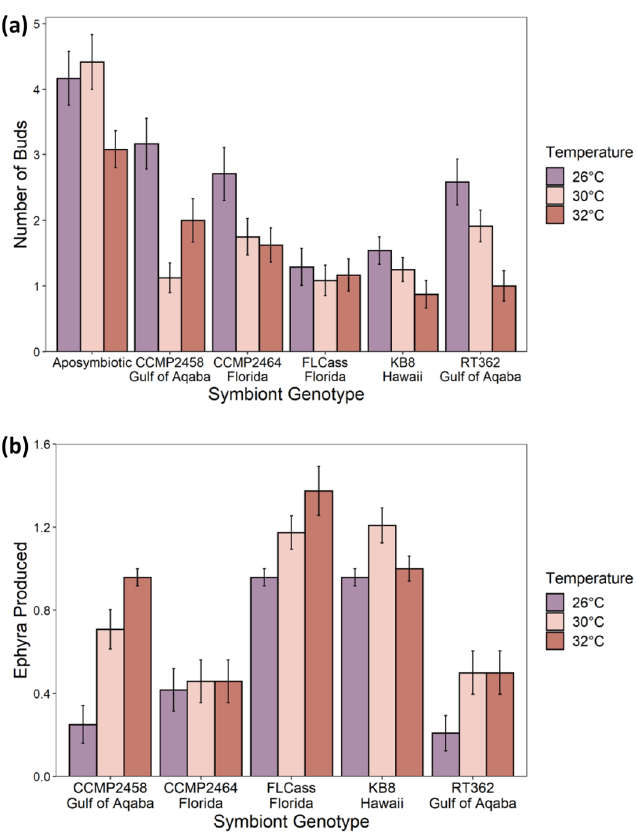
Figure 8. ( a ) Mean (+ SE) total bud production for aposymbiotic polyps and polyps infected with one of five algal genotypes across the three experimental temperatures. ( b ) Mean (+ SE) ephyra production per polyp infected with one of five algal genotypes at each